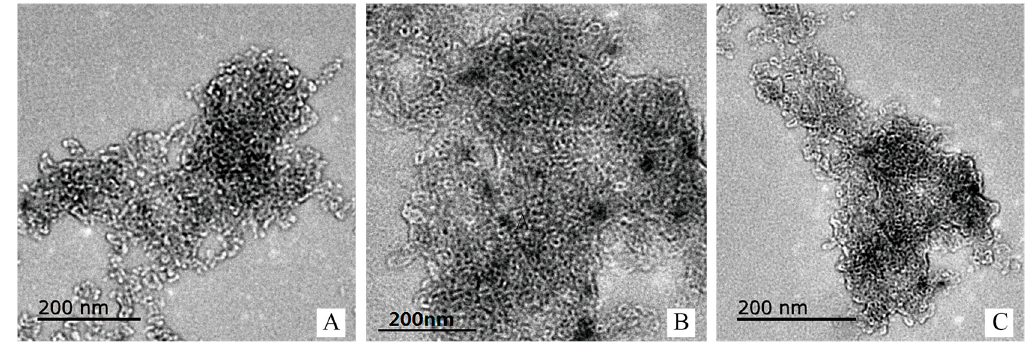
Figure 11. The TEM of SGC with different DS (OSA 0.25 –SG ( A ), OSA 0.5 –SGC ( B ) and OSA 1.0 –SGC ( C )).